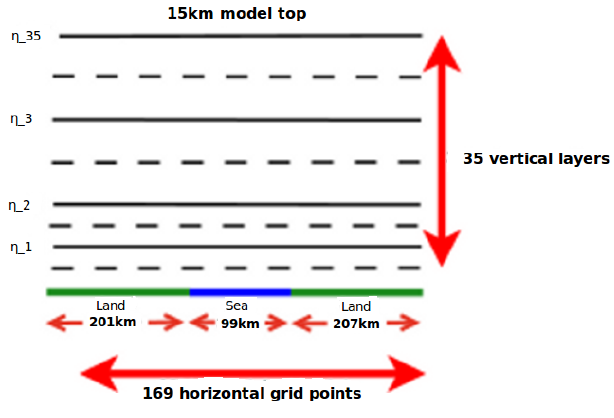
Fig. 6. Model configuration for dual-coast experiments. Dashed lines indicate half levels on the Arakawa C-staggered grid used in the WRF model. Table 2. Sensitivity tests for the dual-coast experiments. The u-wind is orientated shore perpendicular and positive in the offshore direction and the v-wind is shore parallel and positive with land to the left. In all experiments the MYNN level 2.5 scheme is used.